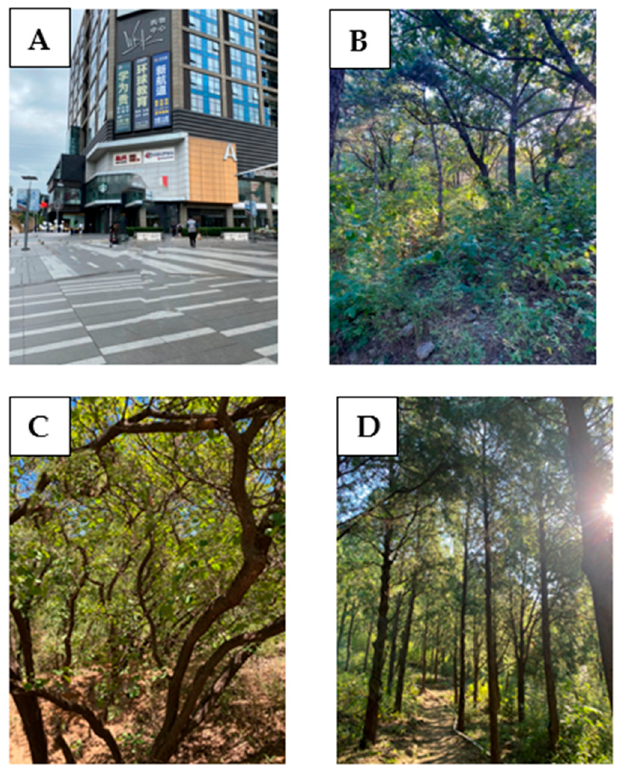
Figure 2. Photos: ( A ) city site, ( B ) mixed forest, ( C ) deciduous forest, ( D ) coniferous